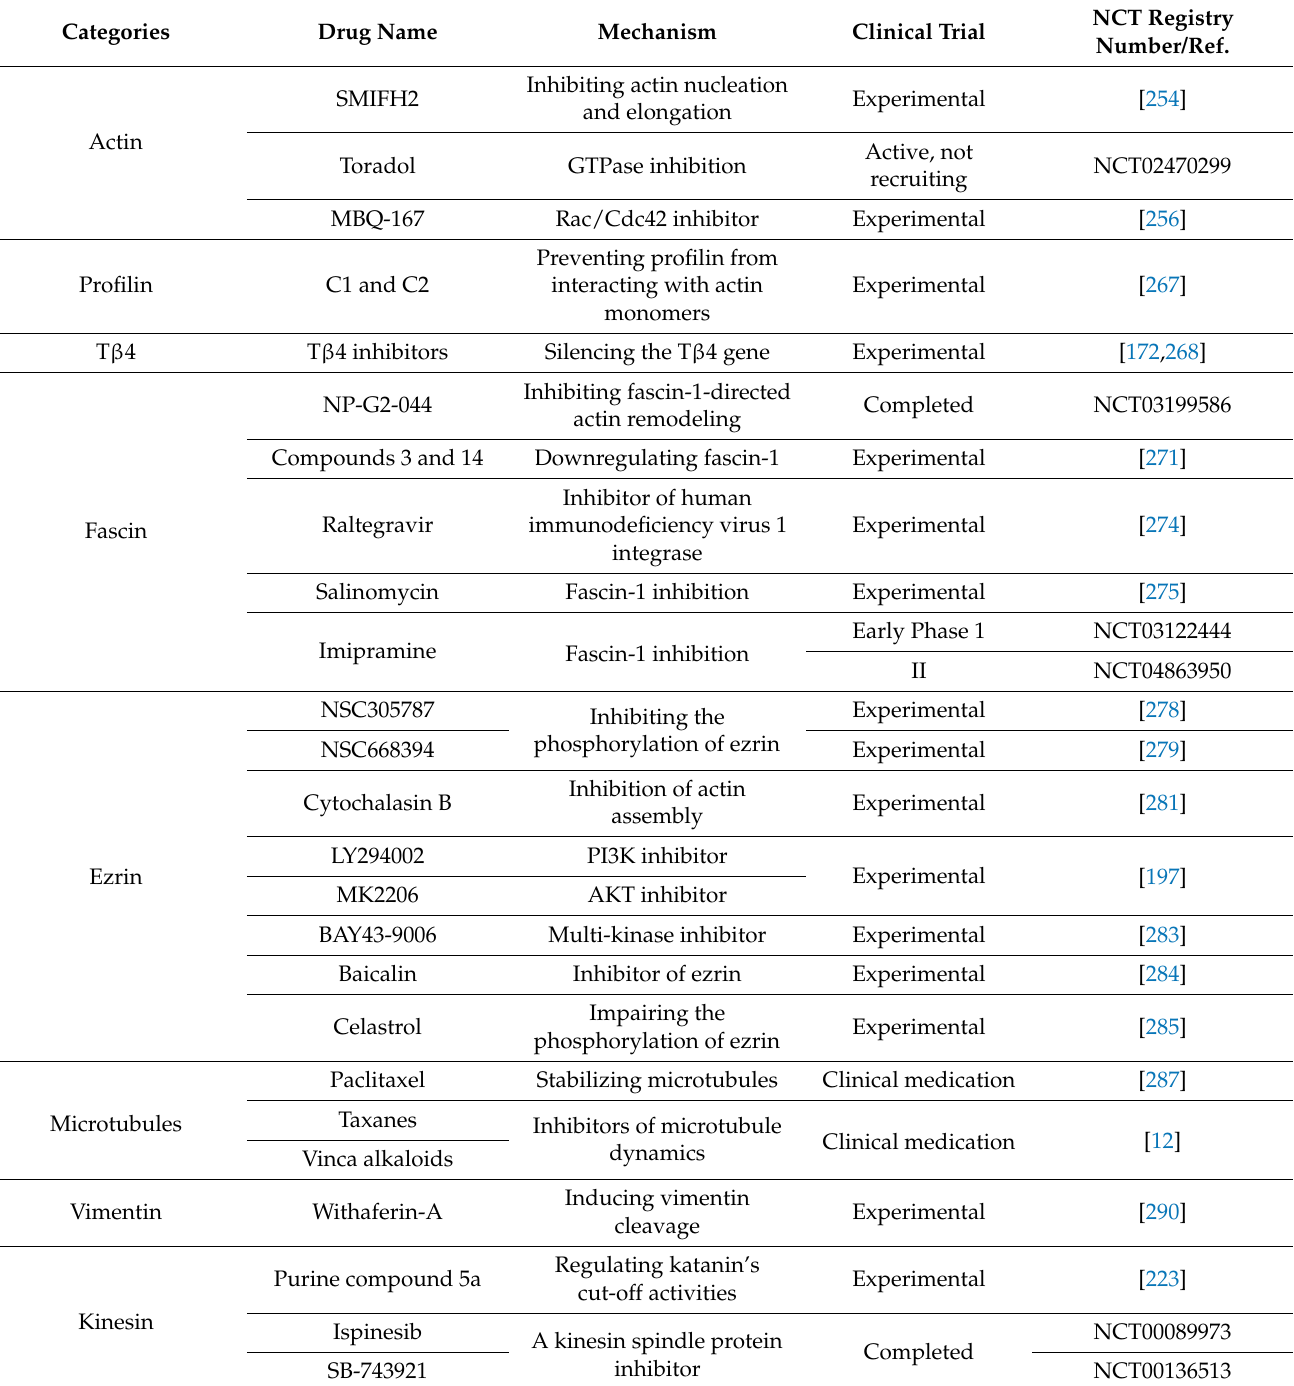
Table 2. Overview of clinical trials and experiments targeting the